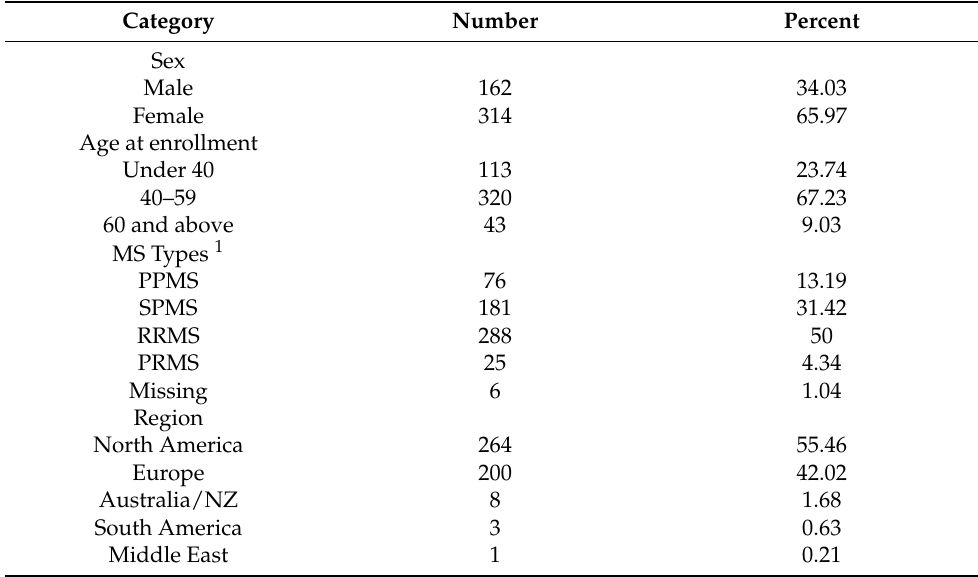
Table 2. Demographic and clinical variables of the study participants.